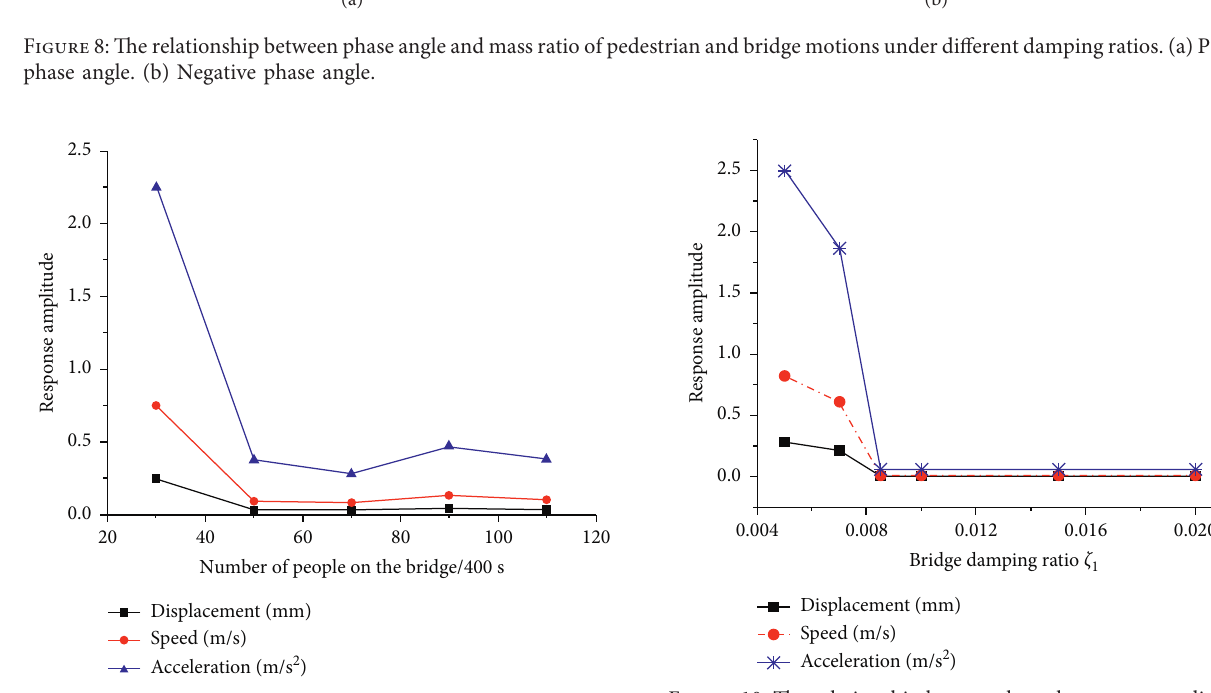
Figure 9: The relationship between dynamic response amplitude and the number of pedestrians on the Millennium Footbridge.